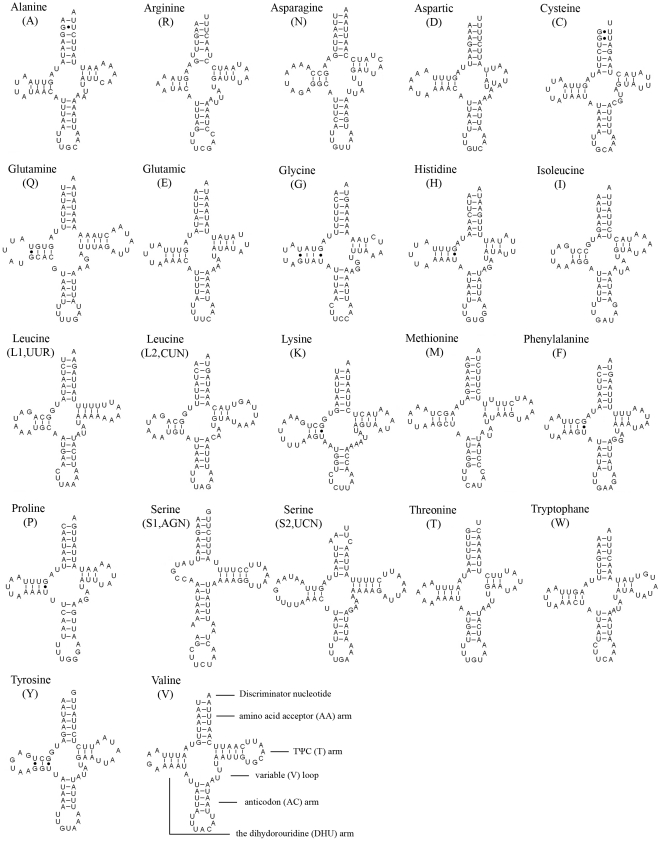
Inferred secondary structure of 22 tRNAs of Stenopirates sp.The tRNAs are labeled with the abbreviations of their corresponding amino acids. Inferred Watson-Crick bonds are illustrated by lines, whereas GU bonds are illustrated by dots.